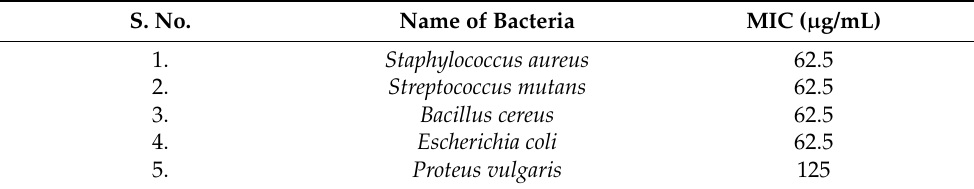
Table 4. Determination of minimum inhibitory concentration (MIC) for different bacterial